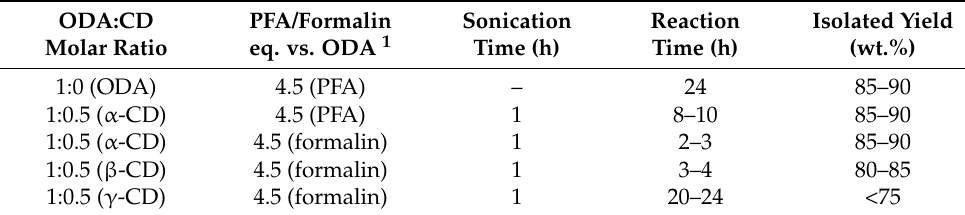
Table 1. Reaction conditions employed for the synthesis of ODA-PHA and